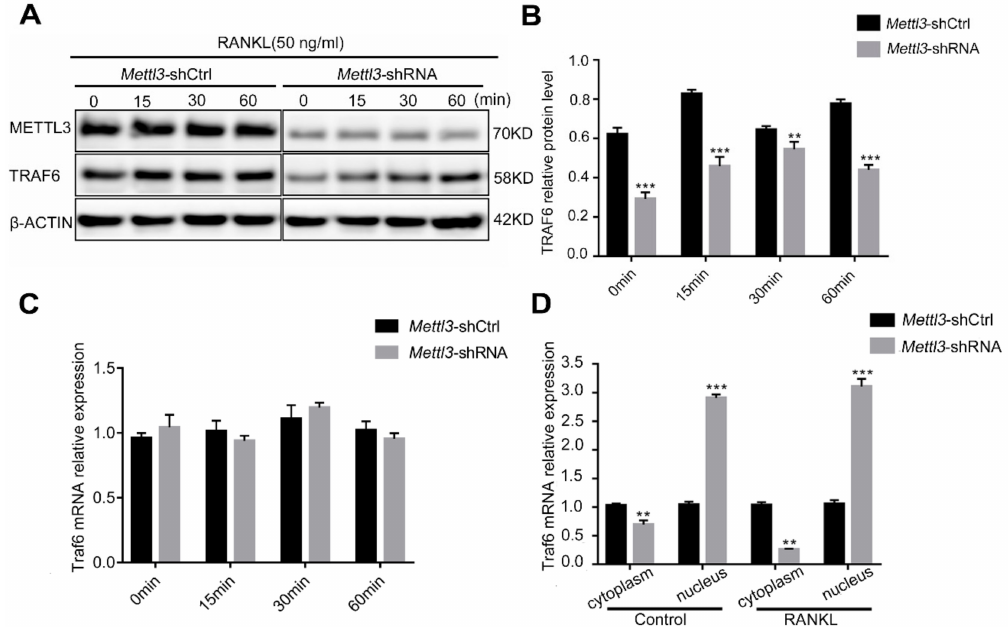
Figure 6. E ff ect of Mettl3 knockdown on nuclear export of Traf6 mRNA. ( A , B ) The protein levels of TRAF6 in the Mettl3 -shRNA and Mettl3 -shCtrl RAW264.7 cells were detected by Western blotting